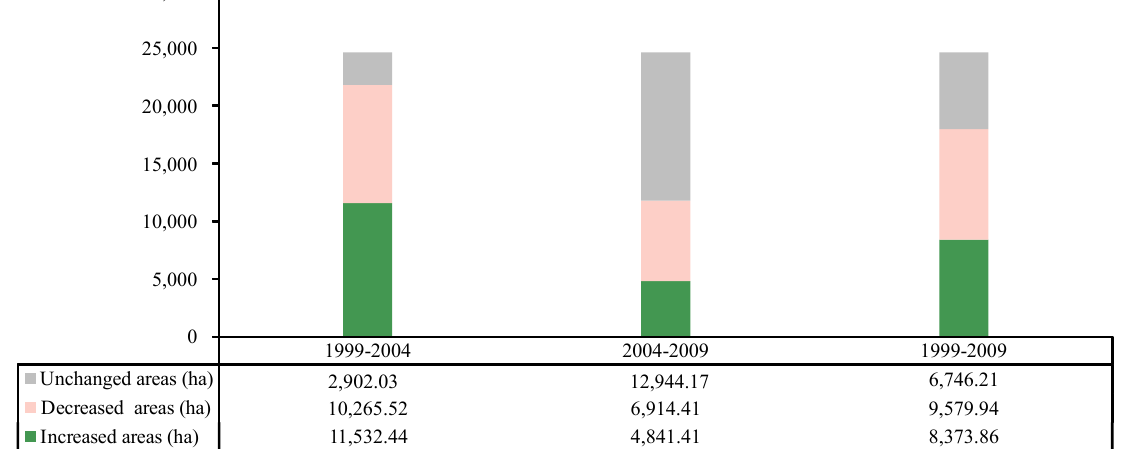
Figure 5. Statistical data for Populus euphratica forest patch changes over the different time